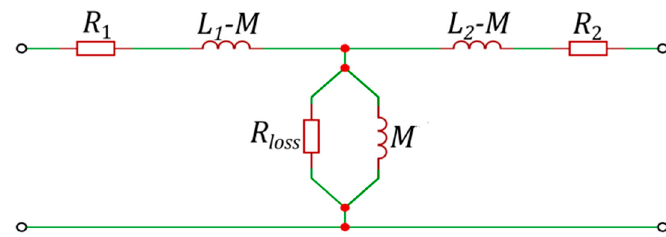
Figure 3. The classical equivalent circuit for the transformer of a WTPS.